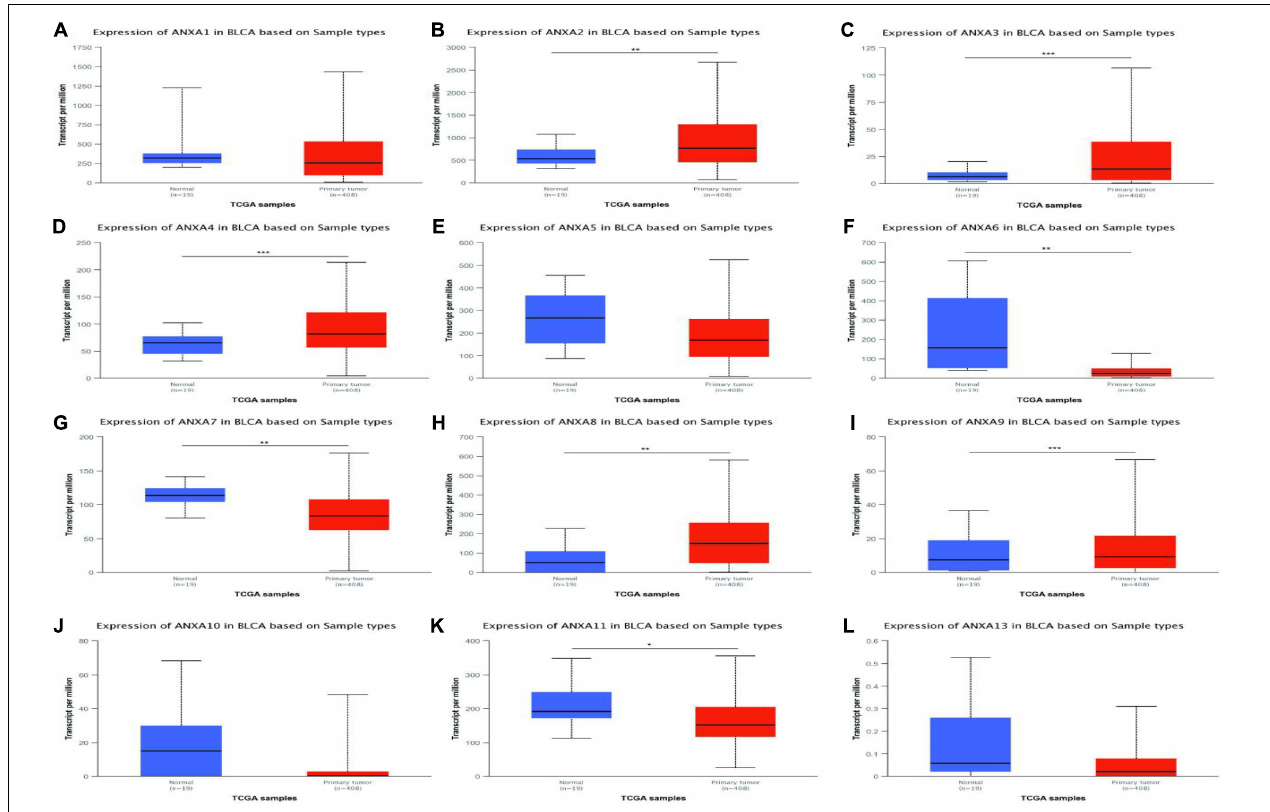
FIGURE 1 | mRNA expressions of different ANXA family members in bladder cancer (TCGA database) (A–L) . (* p < 0.05; ** p < 0.01; *** p < 0.001).